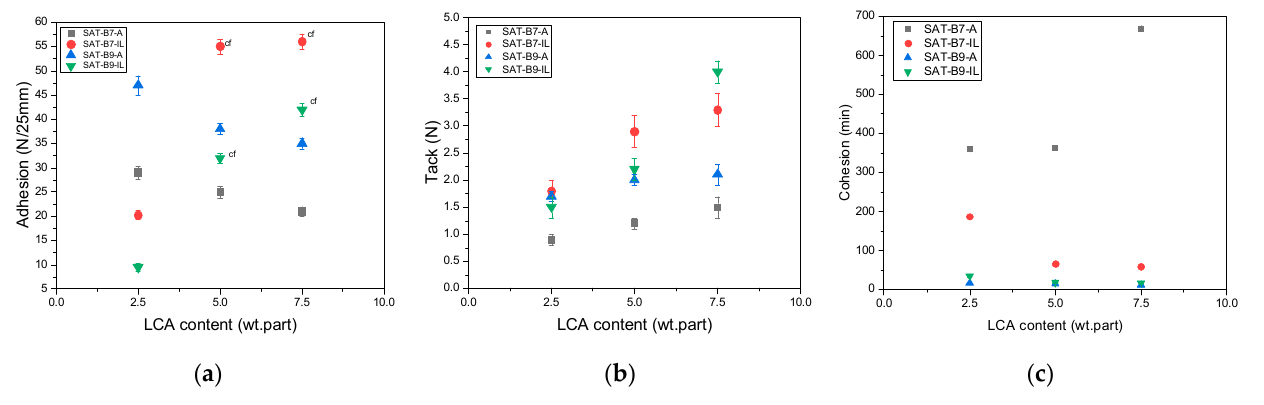
Figure 5. Adhesion to steel ( a ), tack ( b ) and cohesion ( c ) of SATs in relation to the type and content of the latent curing agent (cf-cohesive failure).